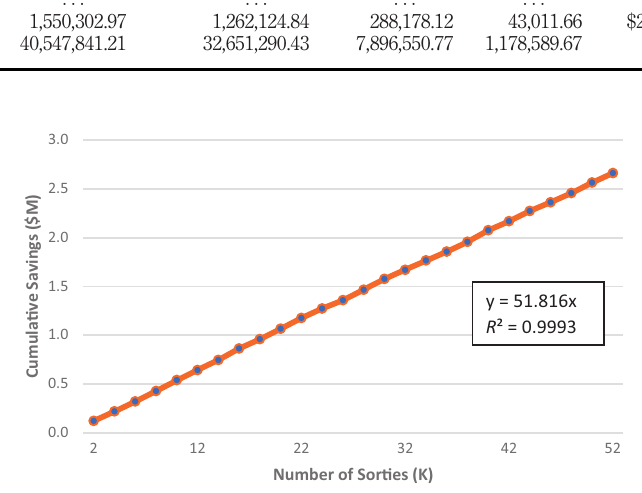
Figure 3. Cumulative savings